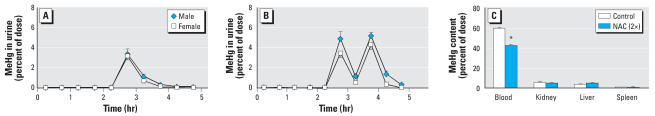
Effect of NAC on urinary MeHg excretion in male and female rats. Animals received [14C]MeHg (0.1 μmol/kg body weight) at time zero and NAC (1 mmol/kg body weight) after 2 hr (A,B); some animals (B) received a second dose of NAC 1 hr later. (C) Residual levels of [14C]MeHg in selected organs at the end of experiments. Values are mean ± SD; n = 4 rats per group.*Significantly different from control (p < 0.05).